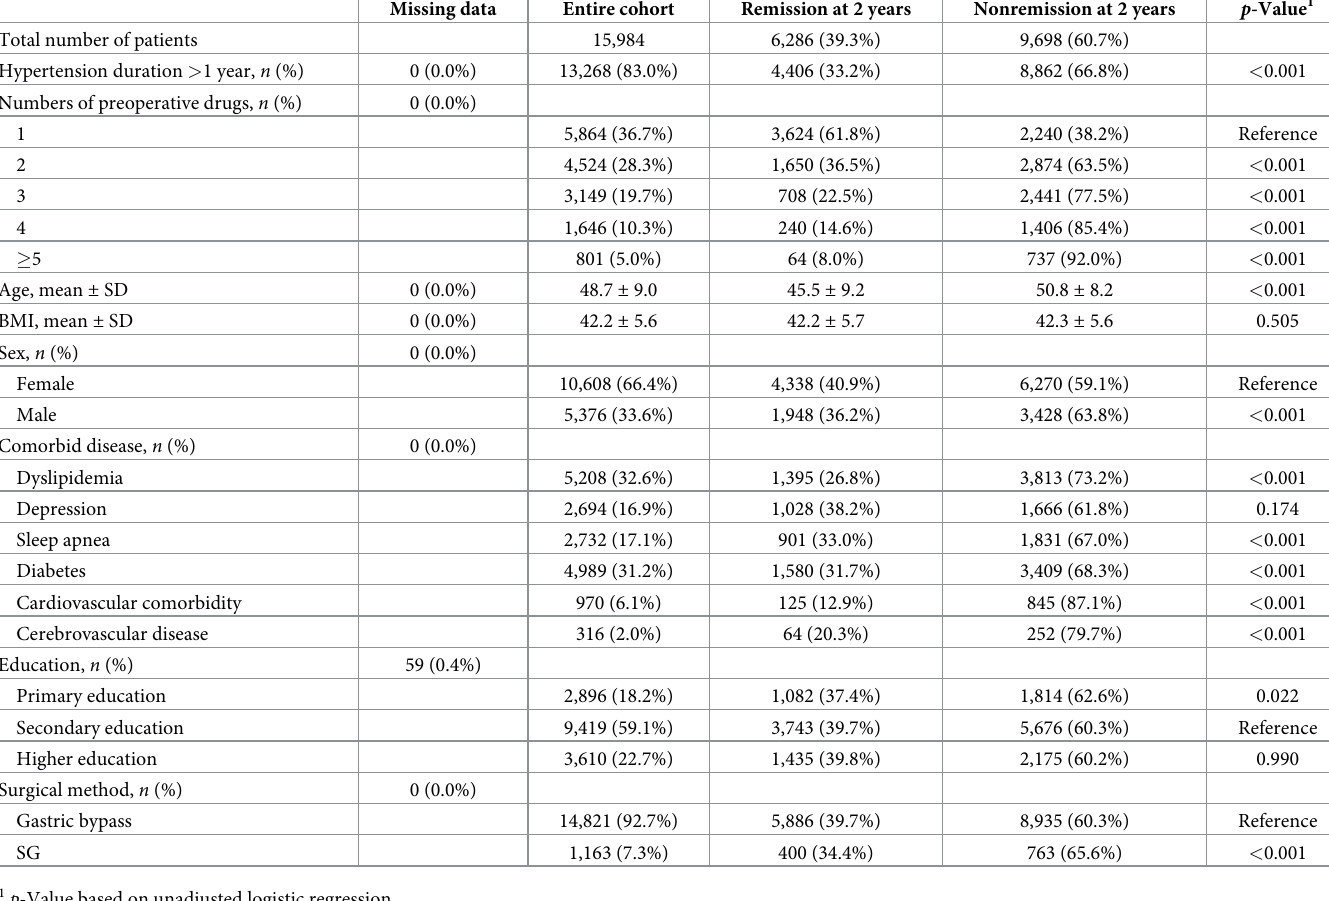
Table 1. Baseline cha racteristics of the study cohort.